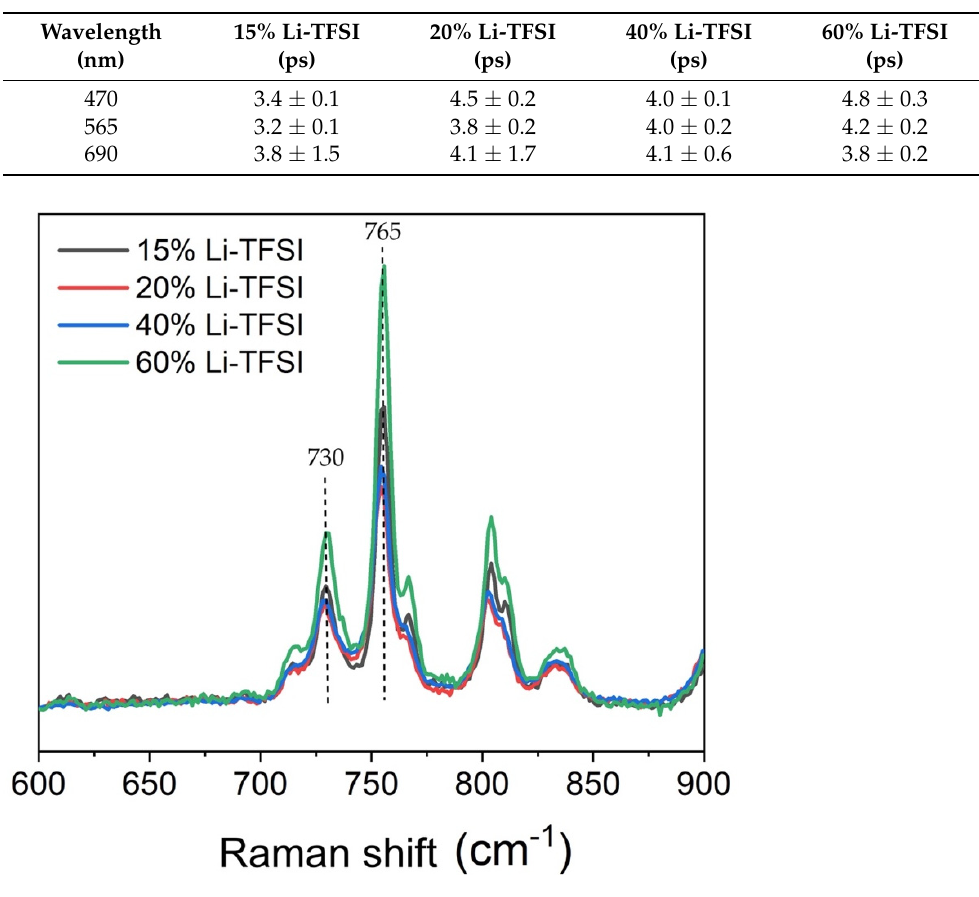
Figure 11. Raman spectra of C-S group in the spiro + TFSI − species and neutral spiro-OMeTAD with different Li-TFSI amounts.